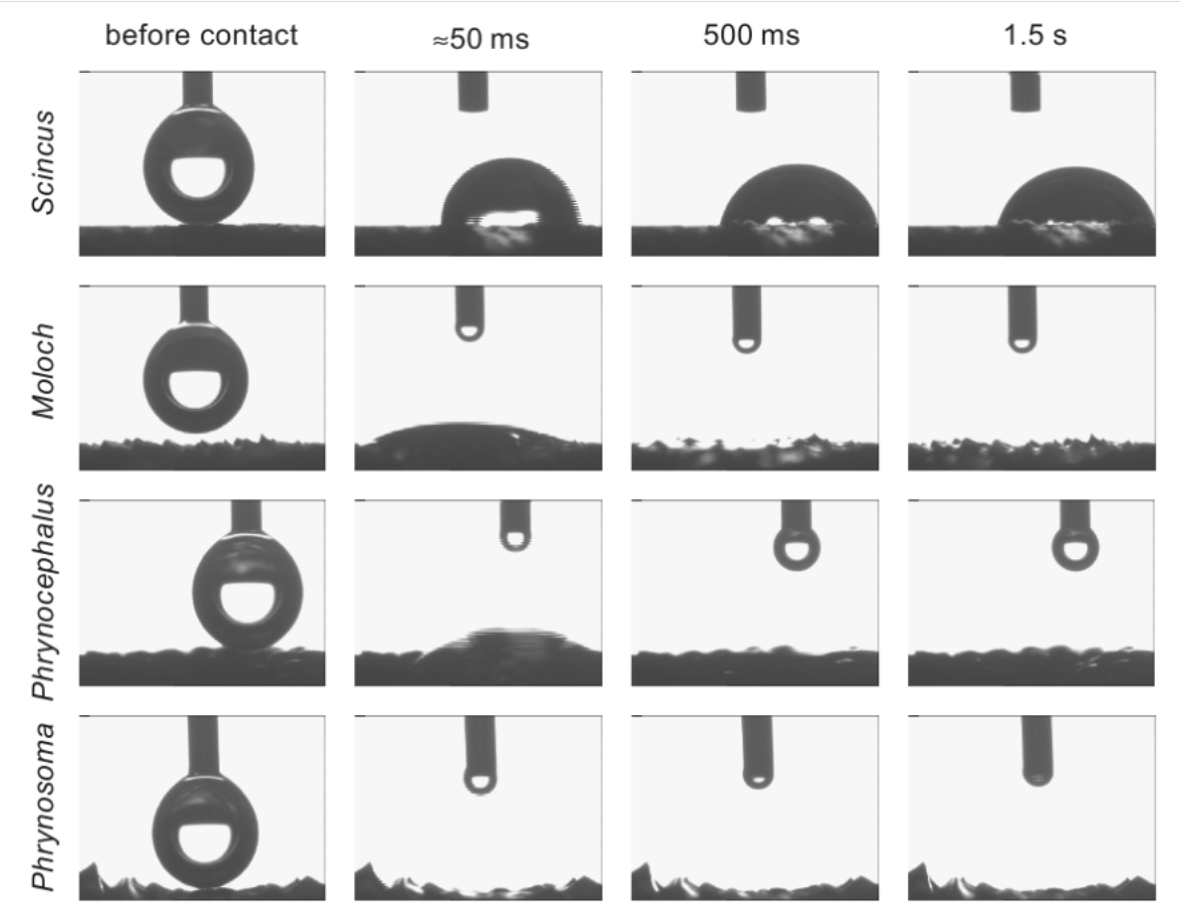
Figure 3: Water spreading on the reptiles' surfaces. A droplet of 5 µl was applied through a syringe and brought into contact with the surface by the use of a micro manipulator. While on the non-moisture harvesting lizard Scincus scincus the droplet hardly changes over time, an almost immediate spreading of the droplet on the moisture harvesting animals, i.e., Moloch horridus , Phrynocephalus arabicus and Phrynosoma cornutum can be seen. The images were recorded with a frame rate of 18 frames per second. Even in the first frame after contact, thus at about 50 ms after the droplet contacts the surface, the droplet is mostly spread and within 2 s the water is completely spread on the surface